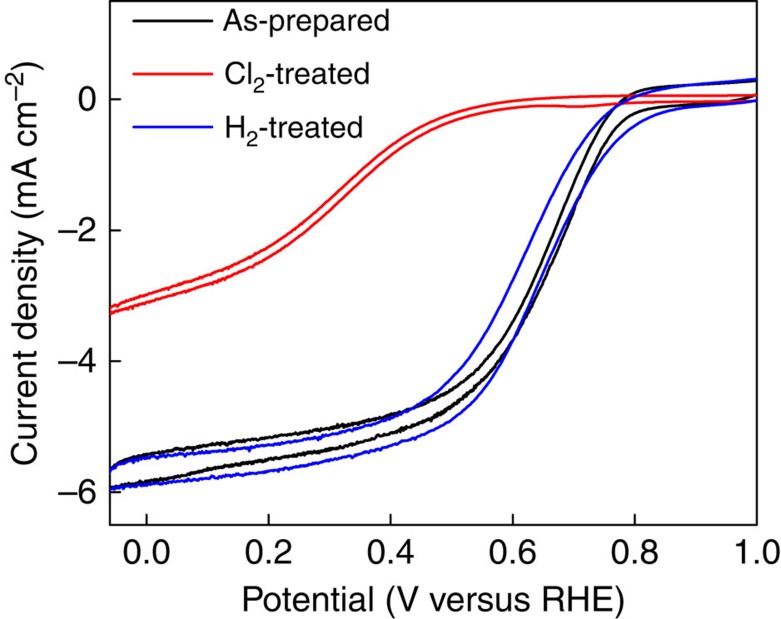
Electrochemical characterization of catalysts.Cyclic voltammograms of ORR on as-prepared, Cl2-treated and H2-treated catalysts in 0.1 M HClO4.